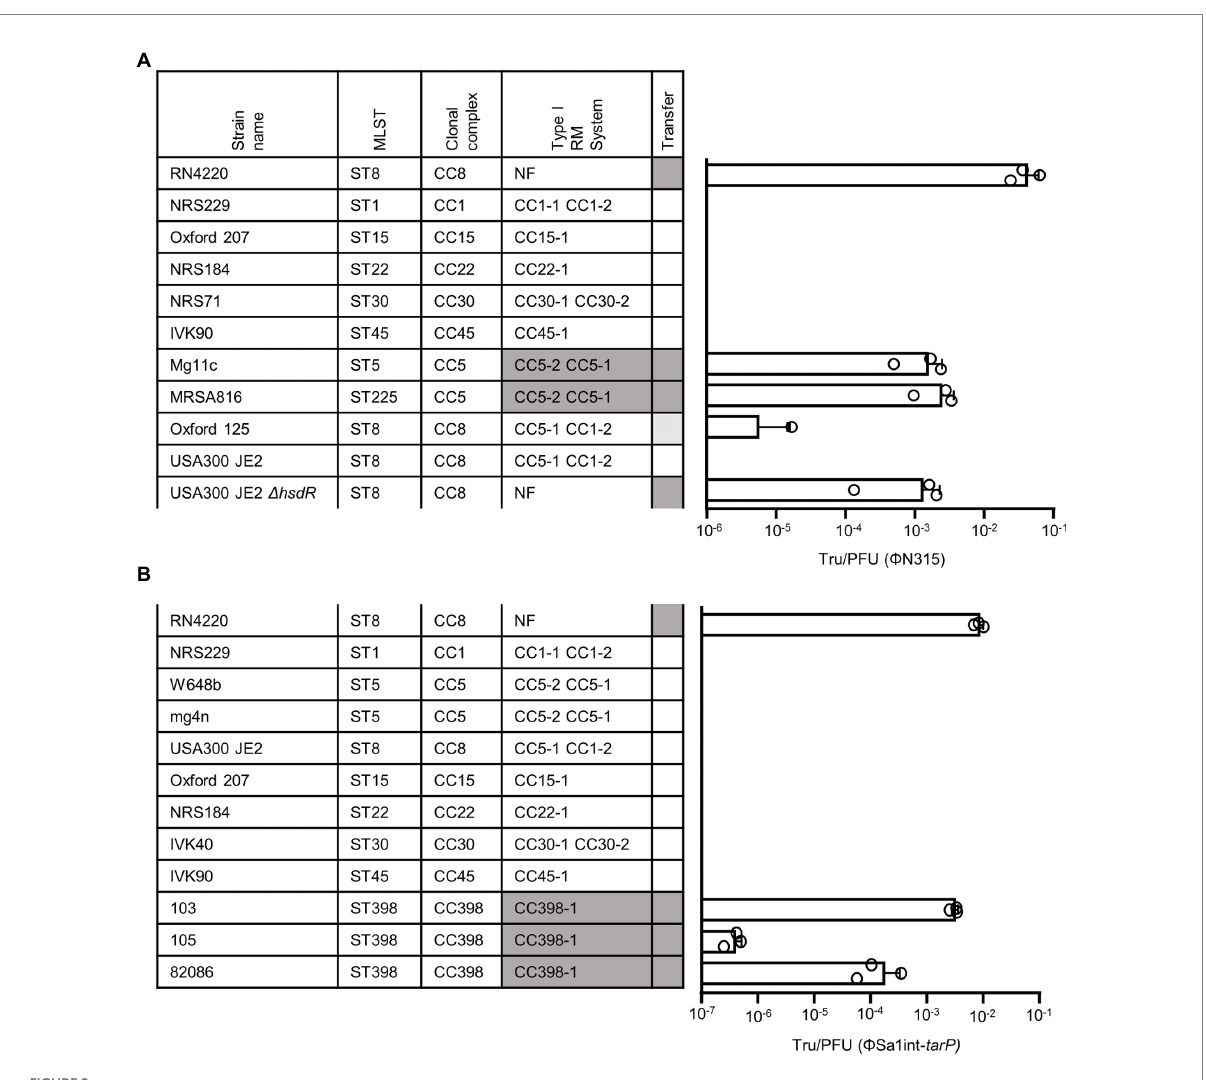
FIGURE 2 Transfer of tarP phages induced from different S. aureus backgrounds into different recipient strains. MLST, clonal complex, associated RM I system make-up, and successful transfer are indicated (NF, non-functional Type I RM system). RM systems that share identical make-up with the donor strain are marked by color. Transfer efficiency is depicted as Tru/PFU as mean + SD of 3 independent replicates. (A) Transfer of Φ N315 induced from a CC5 background. (B) Transfer of Φ Sa1int- tarP induced from a CC398